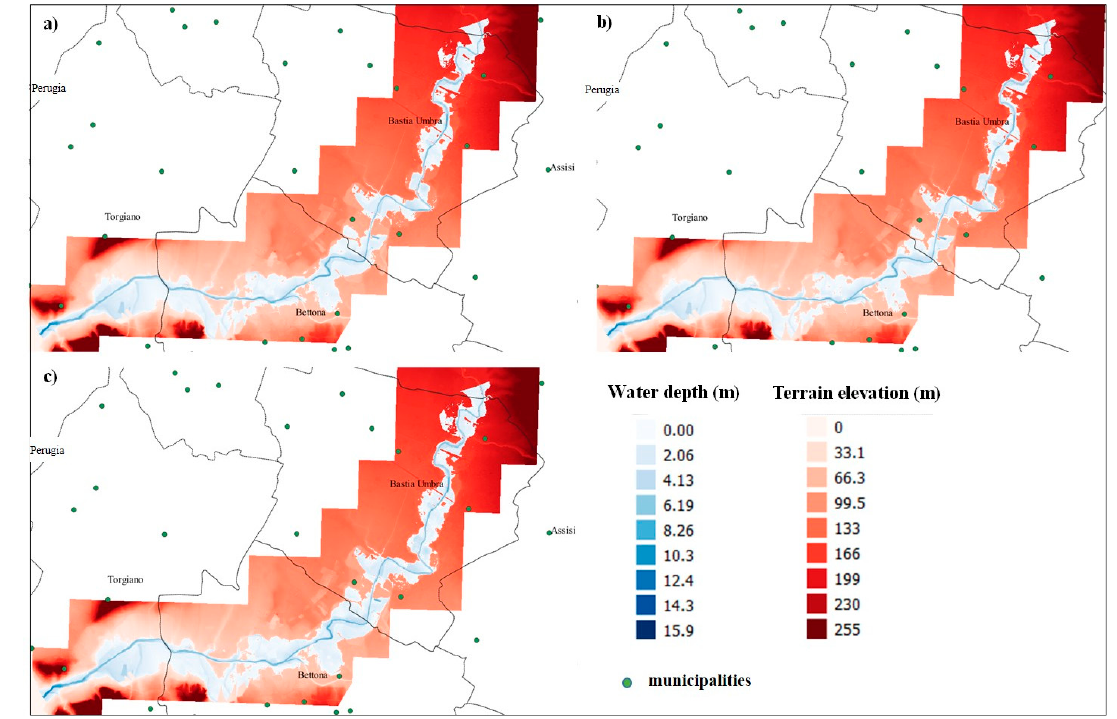
Figure 8. Three maps of the flooded area generated considering the initial water level in the reservoir equals to its maximum value (330 m a.s.l.) and for the three different opening of the outlet gate: closed ( panel a ), half open ( panel b ), open ( panel c ).